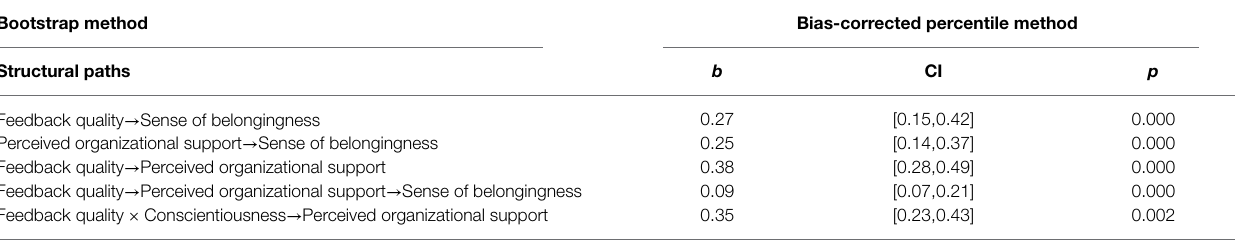
TABLE 3 | Standardized direct, indirect, and interaction effects with lower and upper bound limits. Bootstrap method